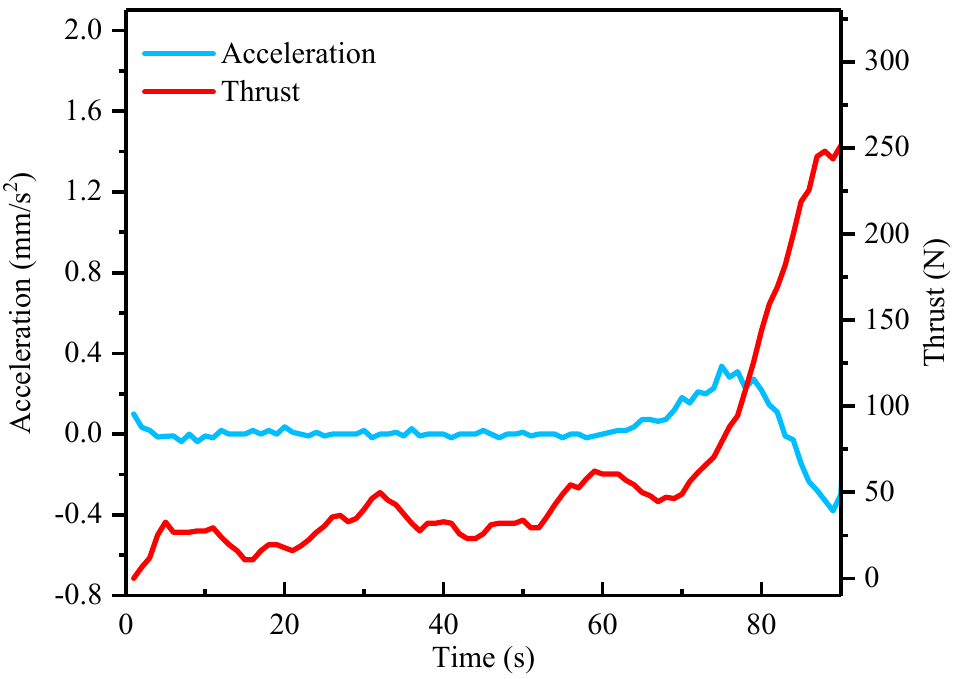
Figure 5. Thrust and acceleration plotted against time with smoothed data.